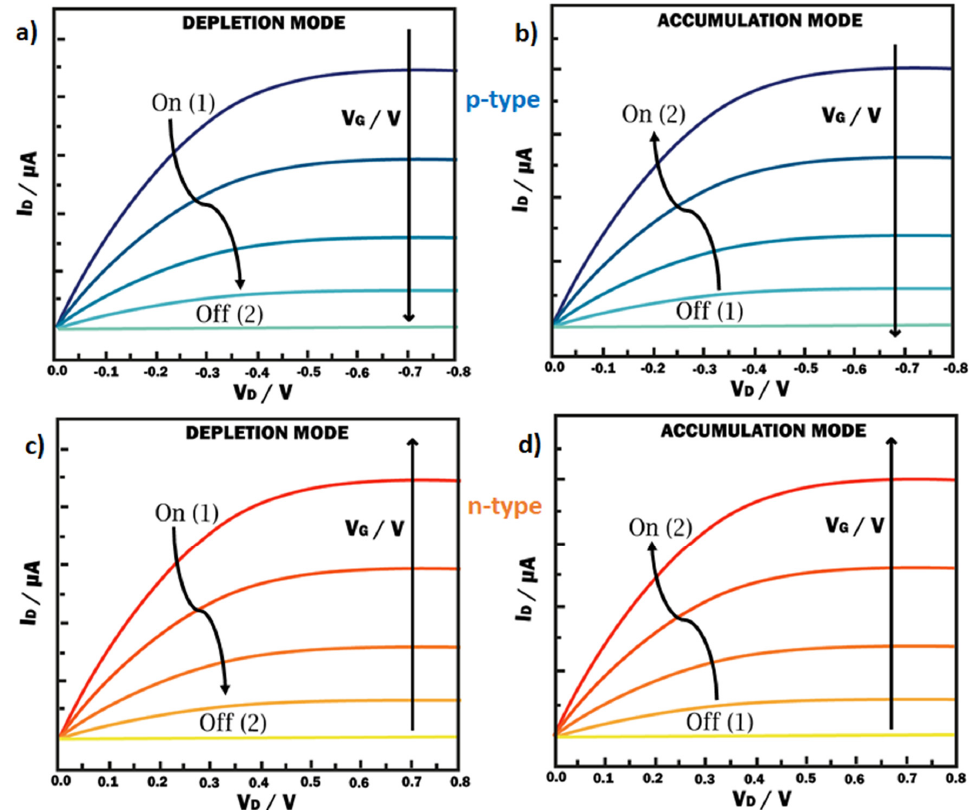
Figure 2. Representative output characteristics of OECT devices. For p-type materials (Blue, Top): ( a ) In depletion mode, under the application of a positive gate voltage ( V G ) cations penetrate into the polymer, dedoping the channel and switching the transistor to its “off” state; ( b ) in accumulation mode, Applying a negative gate voltage ( V G ) results in anions entering the channel material, switching the device to the “on” state. For n-type materials (Red, bottom), both modes of operation are